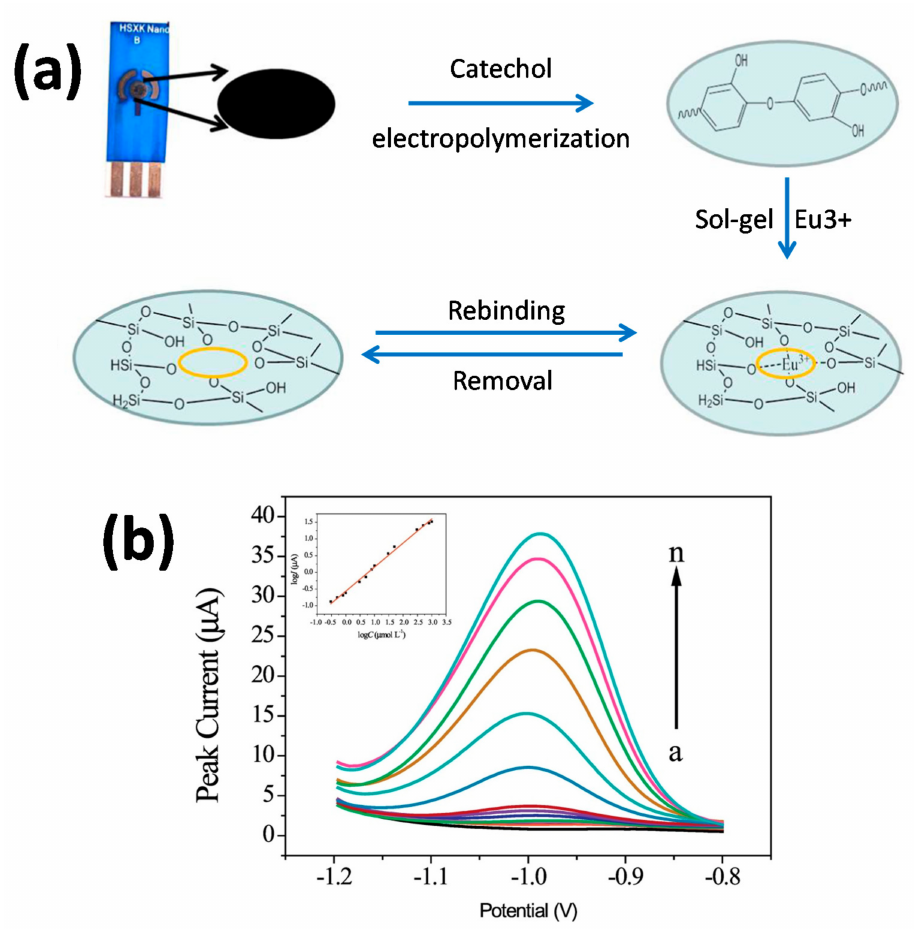
Figure 20. Two step preparation ( a ) and electrochemical Eu(III) sensing performance ( b ) of screen printed electrode coated with polycatechol-IISG bilayer. Adapted with permission of Elsevier from